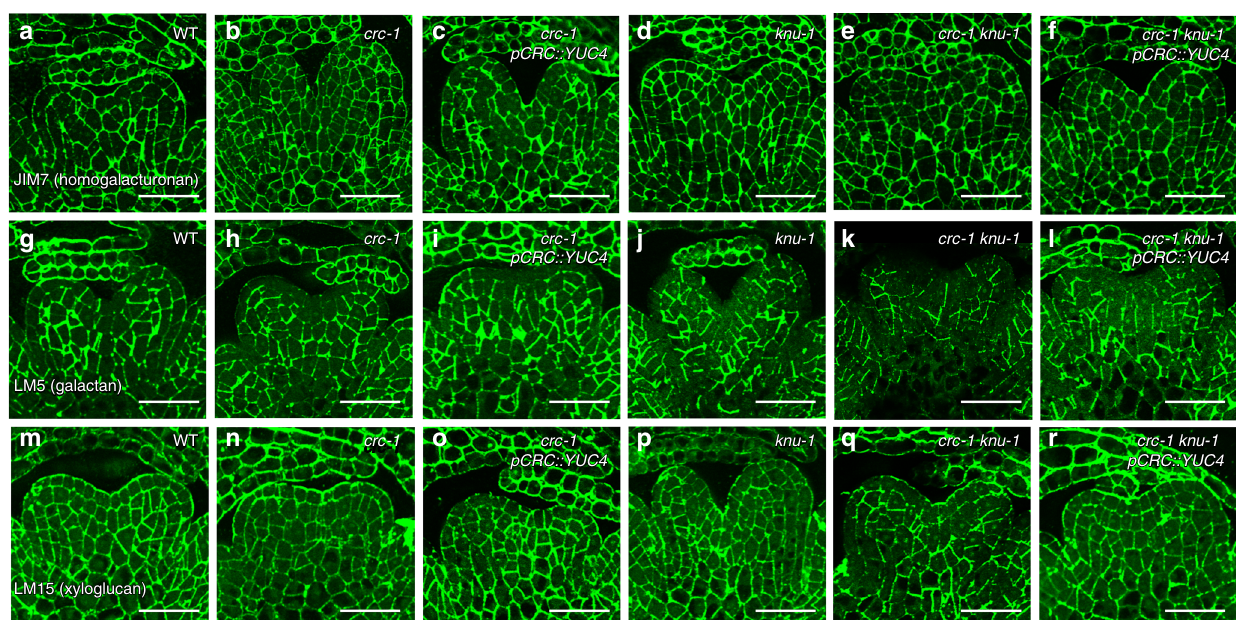
Fig. 6 Rescue of galactan and xyloglucan distribution in the crc knu by ectopic expression of YUC4 . a – f Immunolocalization of homogalacturonan epitopes with JIM7 using longitudinal sections of wild-type ( a ), crc-1 ( b ), crc-1 pCRC::YUC4 ( c ), knu-1 ( d ), crc-1 knu-1 ( e ), and crc-1 knu-1 pCRC::YUC4 ( f ) stage 6 fl oral buds. g – l Immunolocalization of (1-4)-b- D -galactan epitopes with LM5 using longitudinal sections of wild-type ( g ), crc-1 ( h ), crc-1 pCRC::YUC4 ( i ), knu-1 ( j ), crc-1 knu-1 ( k ), and crc-1 knu-1 pCRC::YUC4 ( l ) stage 6 fl oral buds. m – r Immunolocalization of xyloglucan epitopes with LM15 using longitudinal sections of wild-type ( m ), crc-1 ( n ), crc-1 pCRC::YUC4 ( o ), knu-1 ( p ), crc-1 knu-1 ( q) , and crc-1 knu-1 pCRC::YUC4 ( r ) stage 6 fl oral buds. Bars = 50 µ m in a –